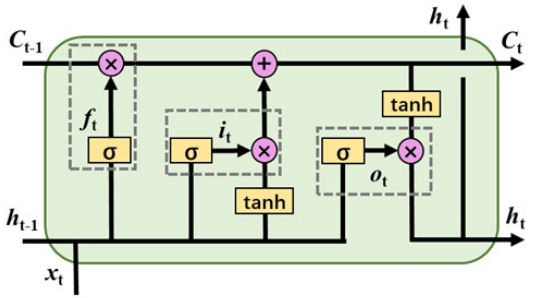
Figure 1. Long − short term memory (LSTM) unit structure.